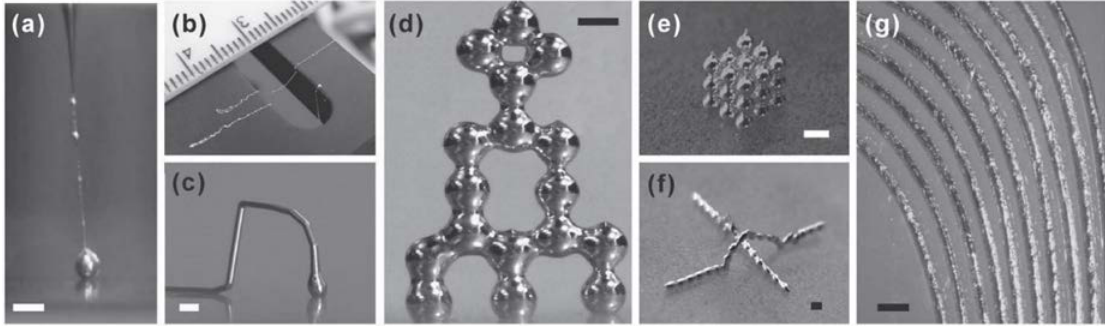
Figure 4. Oxide enabled formation of stable microstructures in liquid metal. Reproduced with permission from [72].